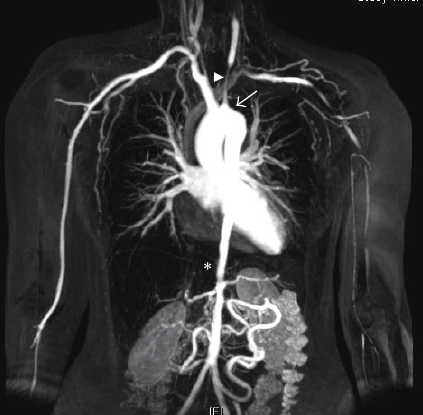
Figure 1: Magnetic resonance angiography in Takayasu arteritis. Contrast-enhanced magnetic resonance angiogram revealing the extent of arterial disease in a young woman with Takayasu arteritis. The left subclavian artery is occluded (arrow) and this has led to collateral formation. There is a long stenosis in the left common carotid artery (arrowhead). The lower thoracic and abdominal aorta is narrow and irregular down to the aortic bifurcation